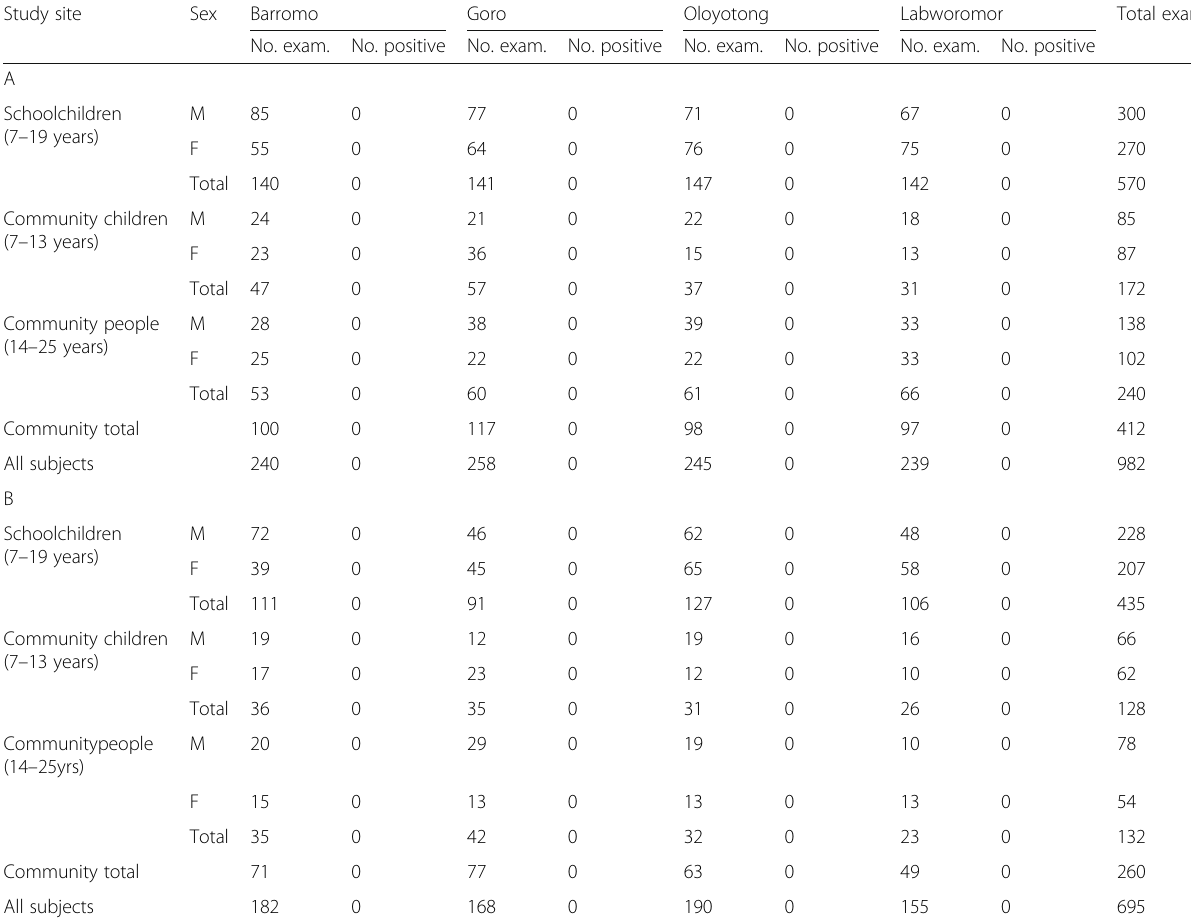
Table 1 Results of W. bancrofti antigen (A) and microfilaria (B) tests according to study site which includes a primary school and surrounding